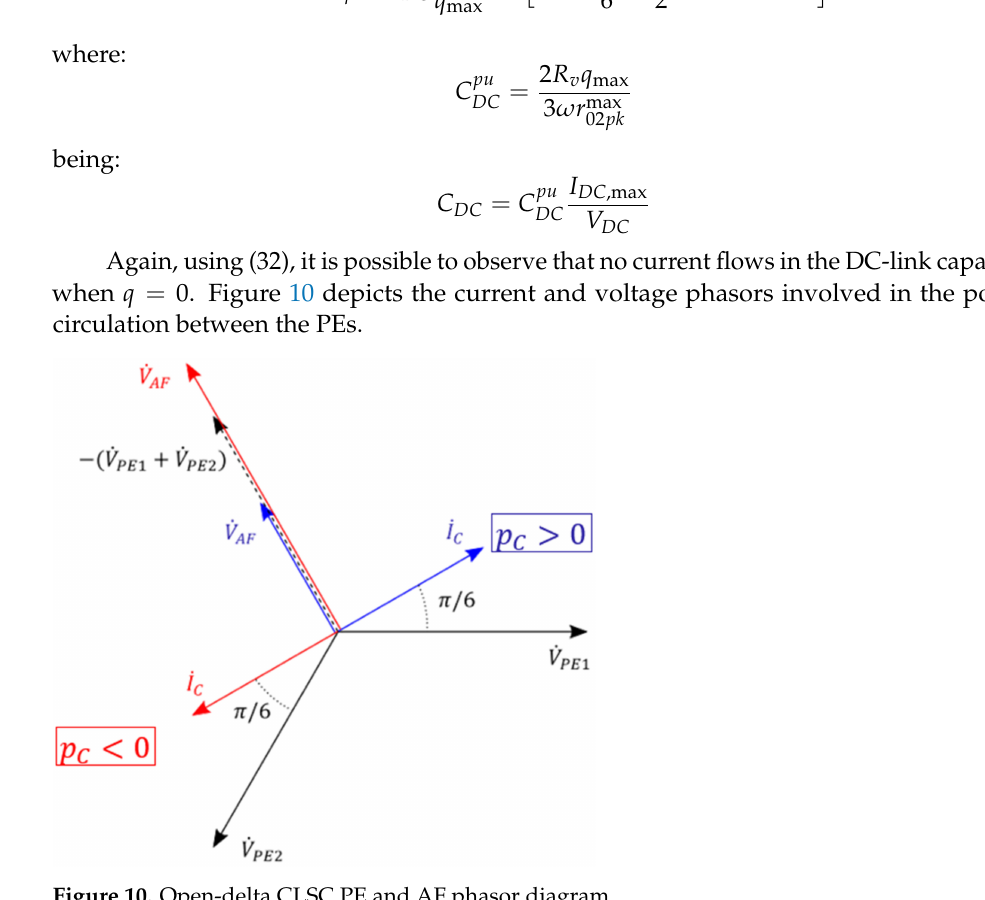
Figure 10. Open-delta CLSC PE and AF phasor